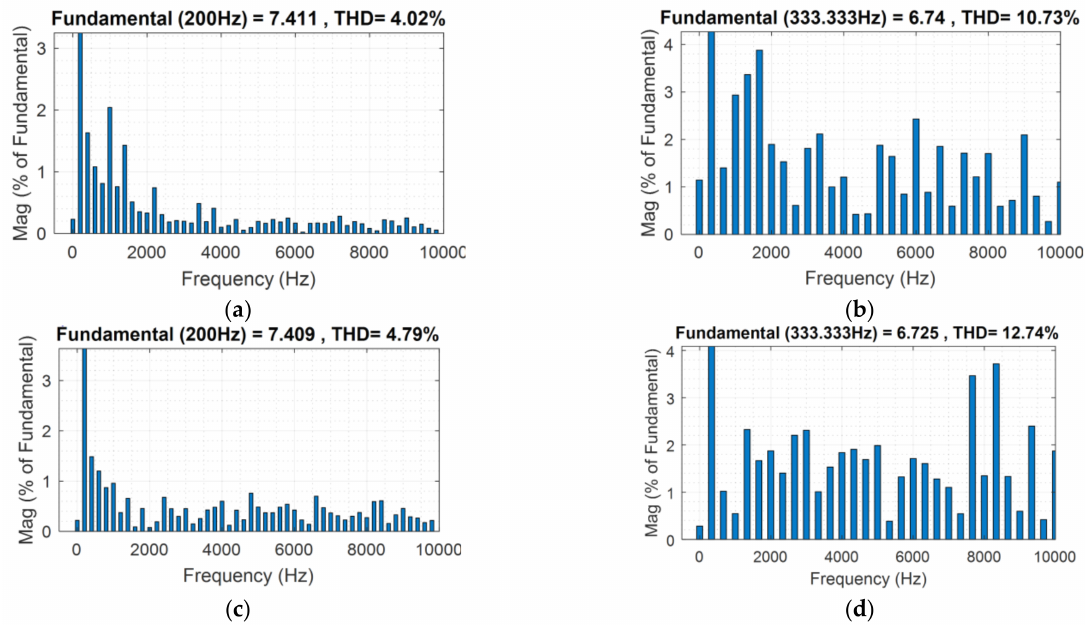
Figure 18. THD of the stator phase-current with the modulated and conventional FCS-MPC: ( a ) M-MPC at a rated speed of